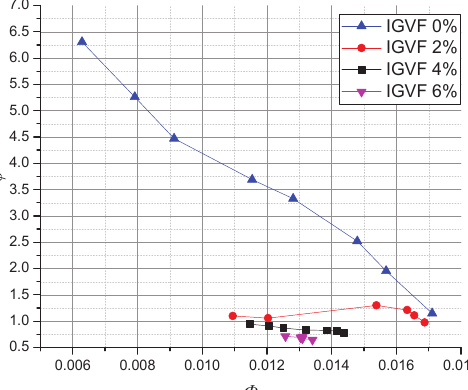
ff erent inlet gas volume fraction Figure 9. Head comparison under different inlet gas volume fraction (IGVF). Figure 9. Head comparison under di